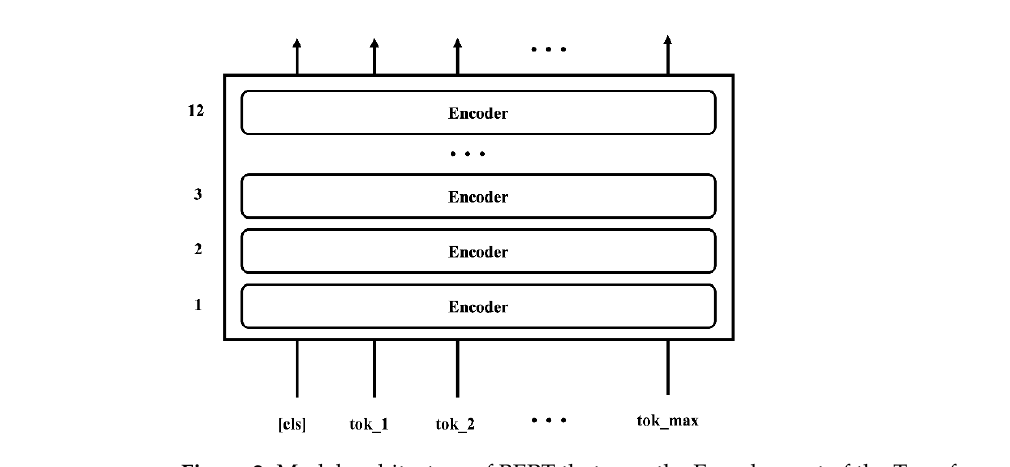
Figure 2. Model architecture of BERT that uses the Encoder part of the Transformer model. (Note: This architecture is also used in the Roberta model.)